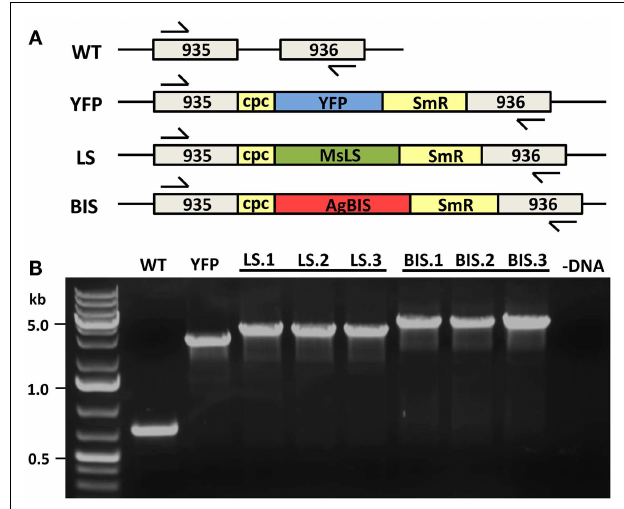
FIGURE 2 | MsLS andAgBIS transgene integration to the Synechococcus chromosome . (A) TheYFP, MsLS, and AgBIS transgene constructs were introduced to a neutral site (NSI) of genomic DNA (between open-reading frames A0935 and A0936) via double homologous recombination. Constructs contained the Synechocystis sp. PCC 6803 cpcBA ( cpc ) promoter to drive transgene expression, and a spectinomycin-resistance selectable marker (SmR). Arrows indicate the position of genomic DNA primers used to check for integration and complete chromosomal segregation in transformant lines. (B) Verification of compete chromosomal segregation for the introduced transgenes inYFP, LS, and BIS transformants by colony-PCR using the above-mentioned primers.Three independent transformant lines of LS (LS.1, LS.2, and LS.3) and BIS (BIS.1, BIS.2, and BIS.3) were